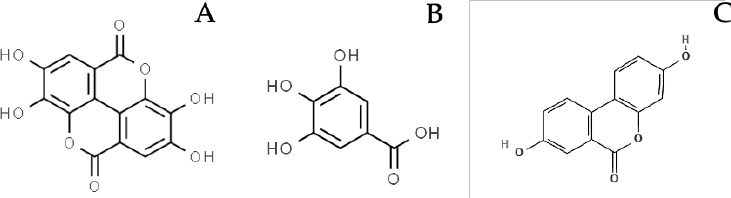
Figure 2. Examples of compounds deriving from HTs hydrolysis and gut metabolism, cited in the main text: A. Ellagic acid; B. Gallic acid; C. Urolithin A.